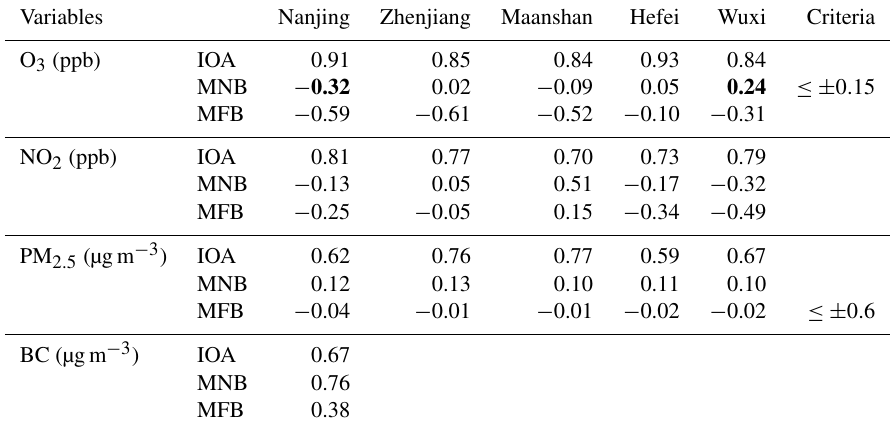
Table 3. Statistical metrics for air pollutants from 10 to 26 October 2015. Criteria for ozone and PM 2 . 5 are suggested by EPA (2005) and EPA (2007). The values that do not meet the criteria are denoted in bold. Variables Nanjing